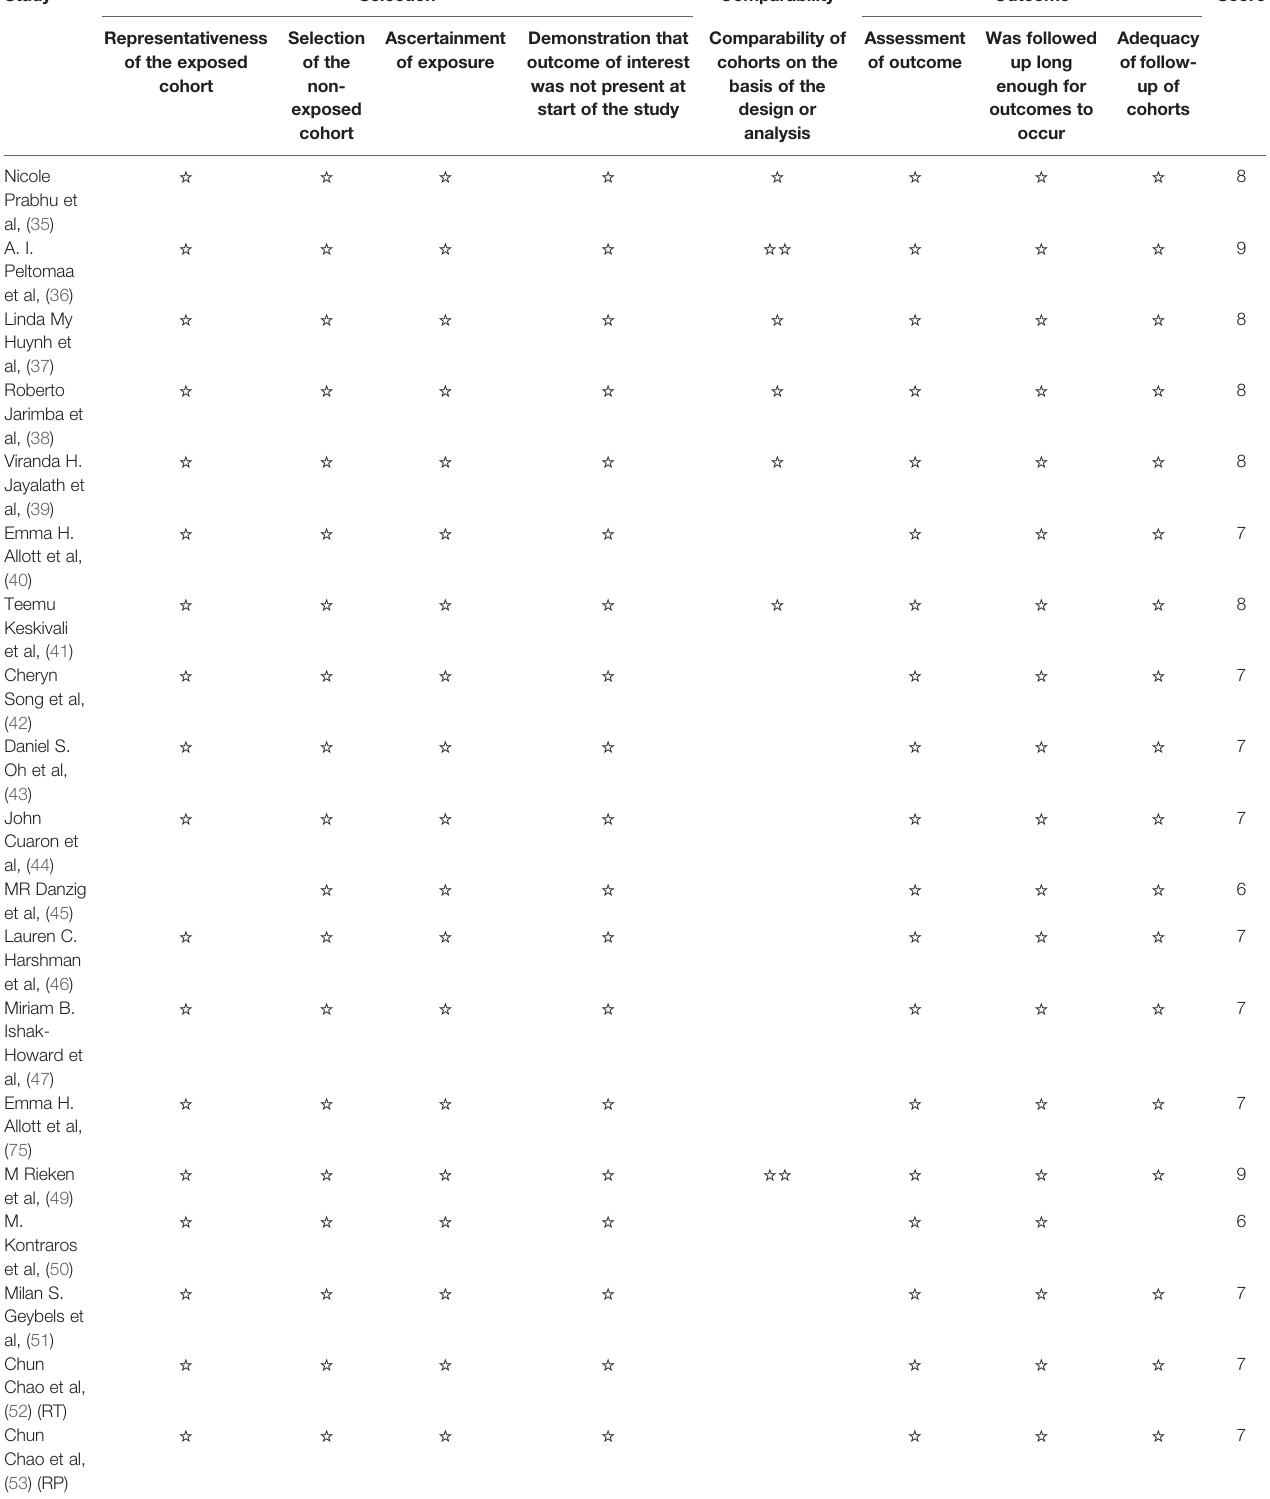
TABLE 2 | Newcastle – Ottawa Scale for assessing the quality of studies in meta-analysis.